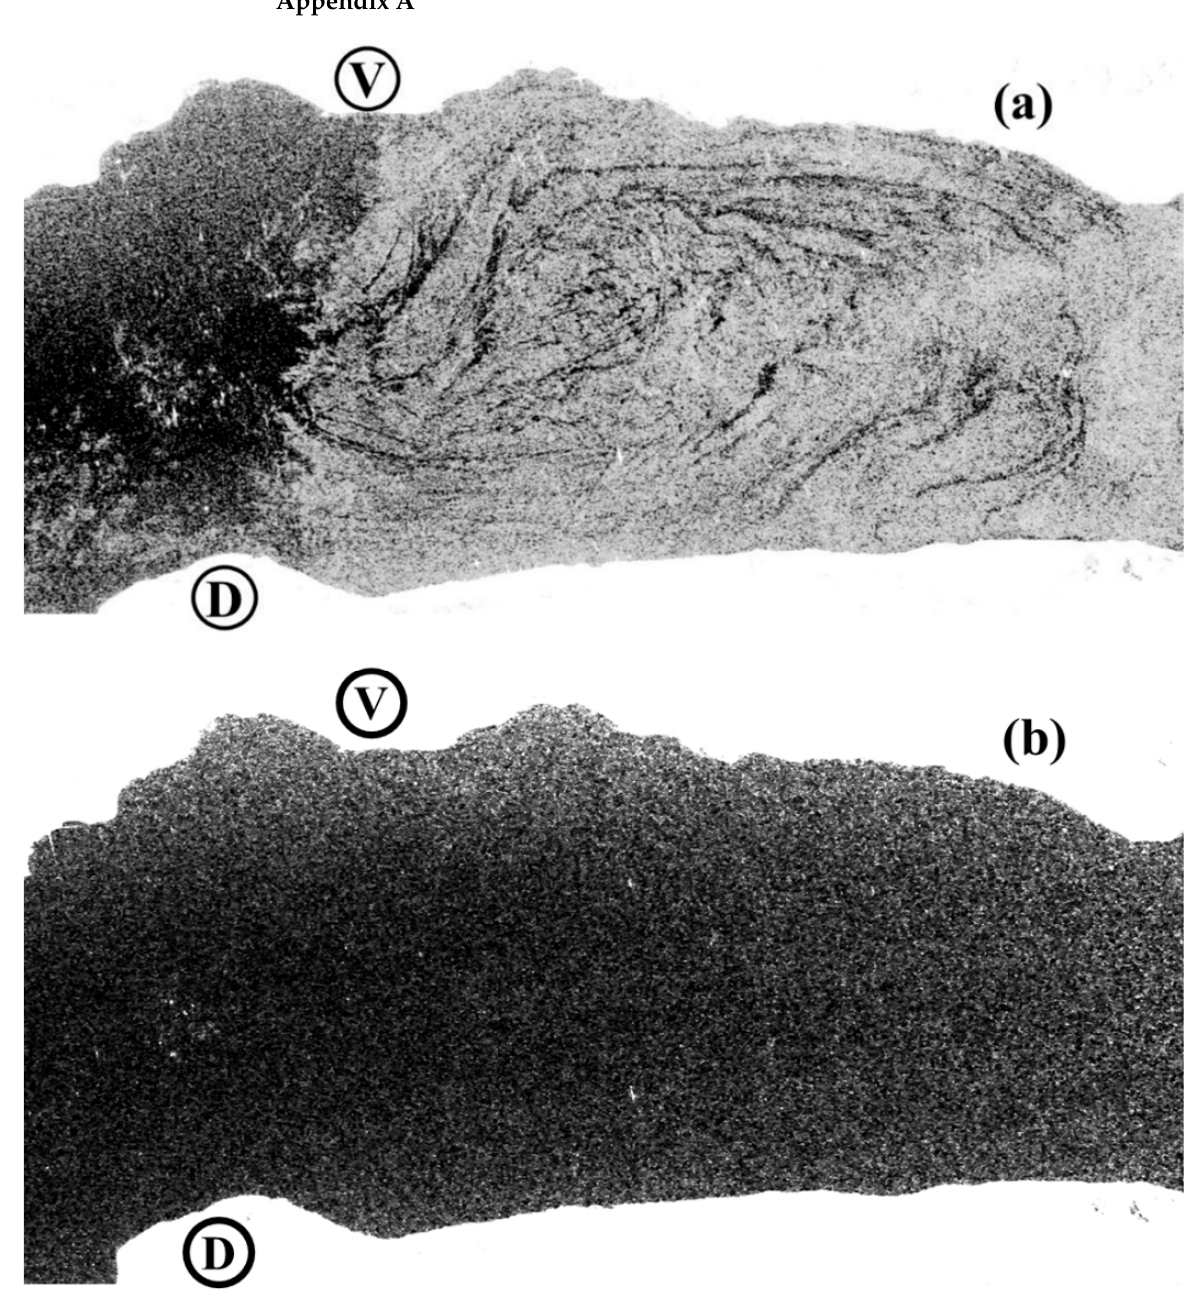
Figure A1. Subset of a Sentinel-1B SAR-C image acquired on 21 July 2018 at 17:31 UTC ( a ) co-polarization (VV), and ( b ) cross-polarization (VH). V and D: reference points marked in Figure 1.